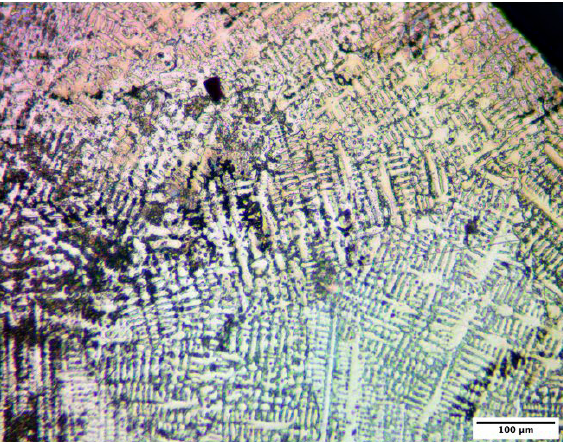
Figure 10. Detailed microstructural section of the x-z plane (x being the torch moving direction and z being the height) of the Inconel 718 30-layer wall structure.